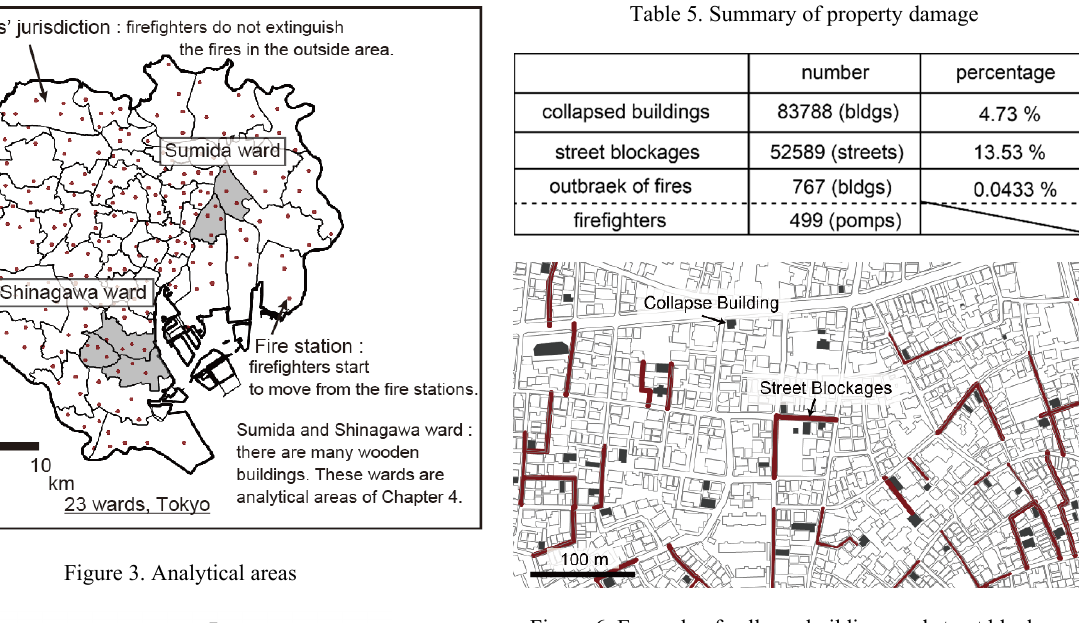
Figure 6. Example of collapse buildings and street blockages